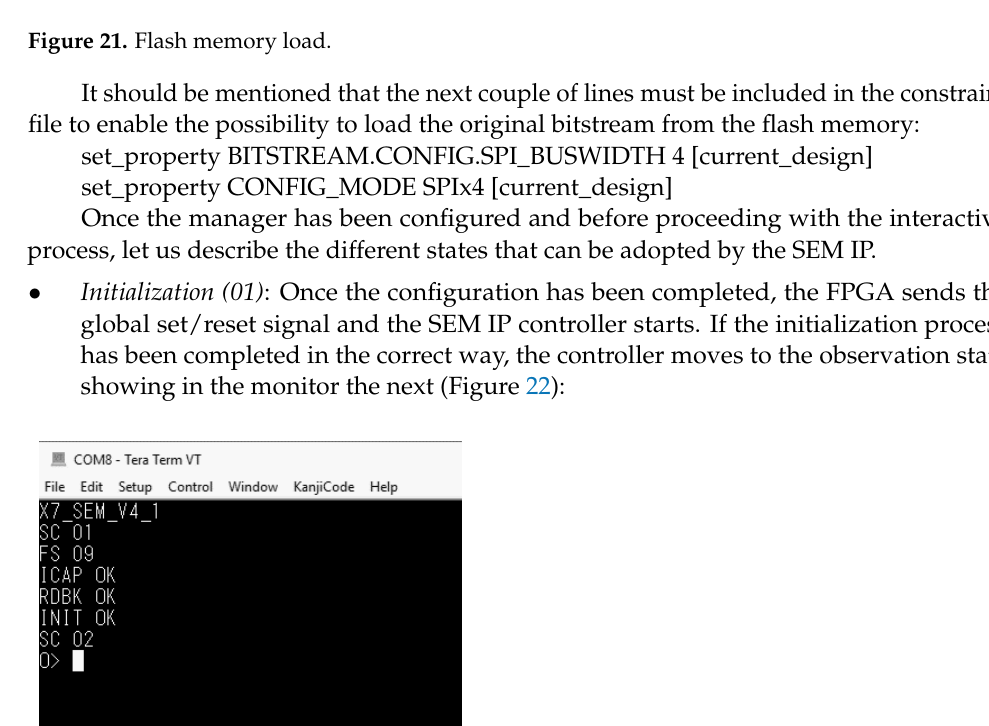
Figure 21. Flash memory load.